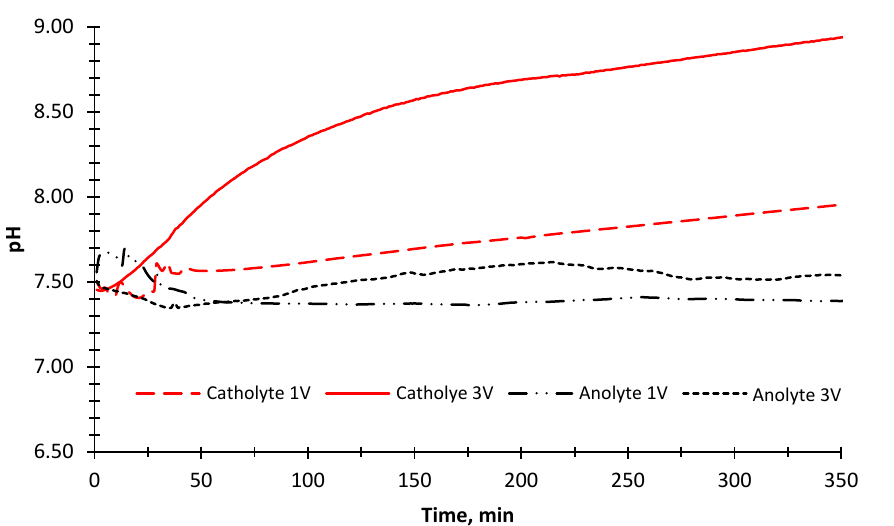
Figure 7. The change of pH values of the anode and cathode solutions (BTTWW) during the desalination experiment with 1 V and 3 V applied potentials and illuminated with the sun simulator.